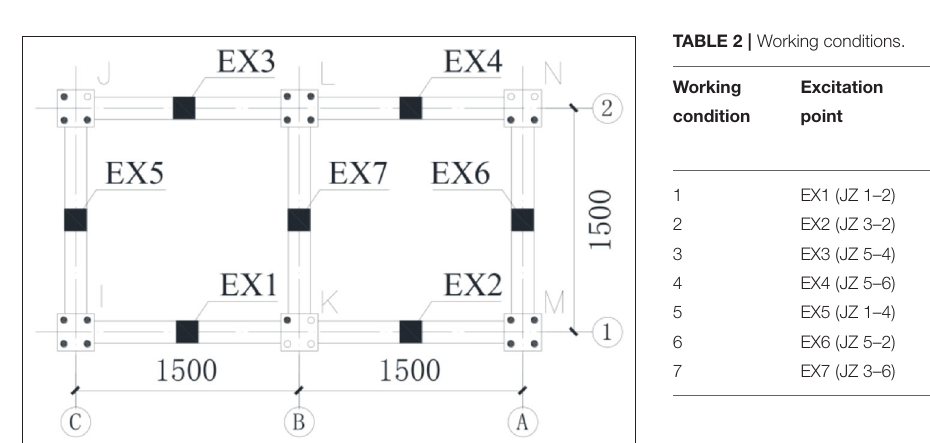
FIGURE 9 | Defect setting of the second floor and excitation point arrangement. Solid dots represent grouting sleeves and hollow dots represent ungrouted sleeves. EX represents the excitation point